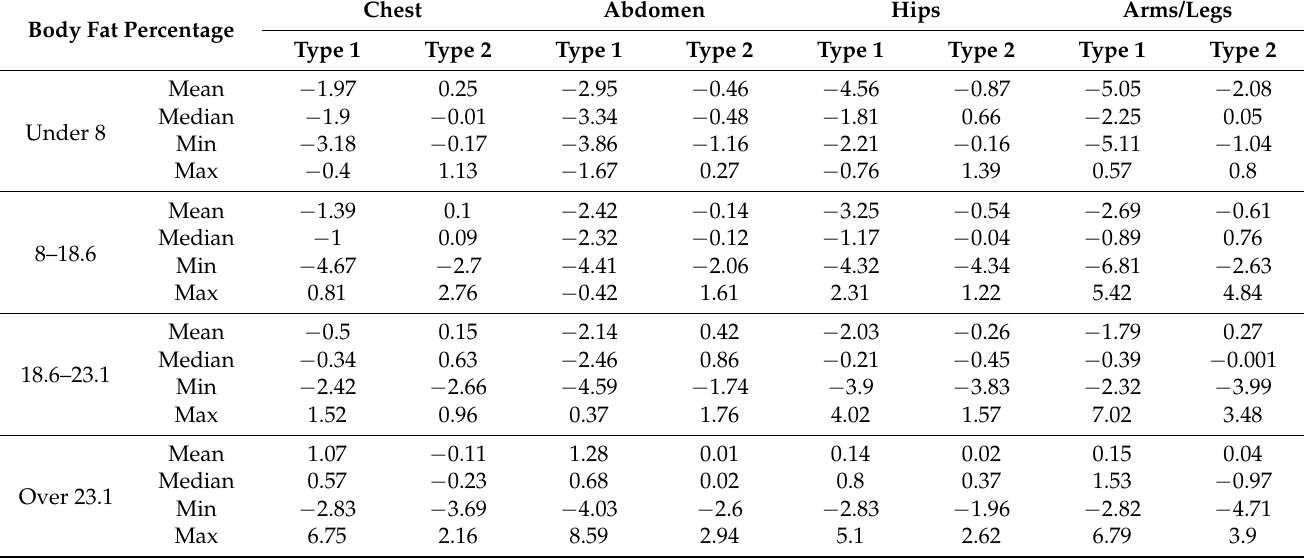
Table 6. Results for men.